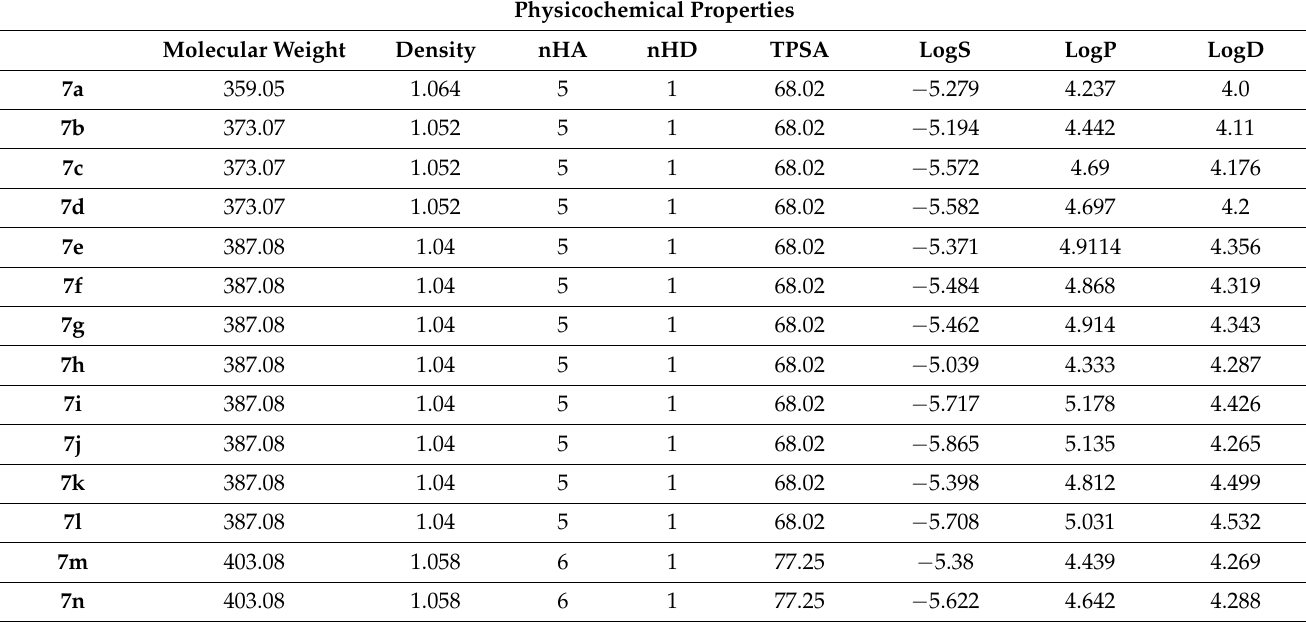
Table 6. Various physicochemical properties of selected